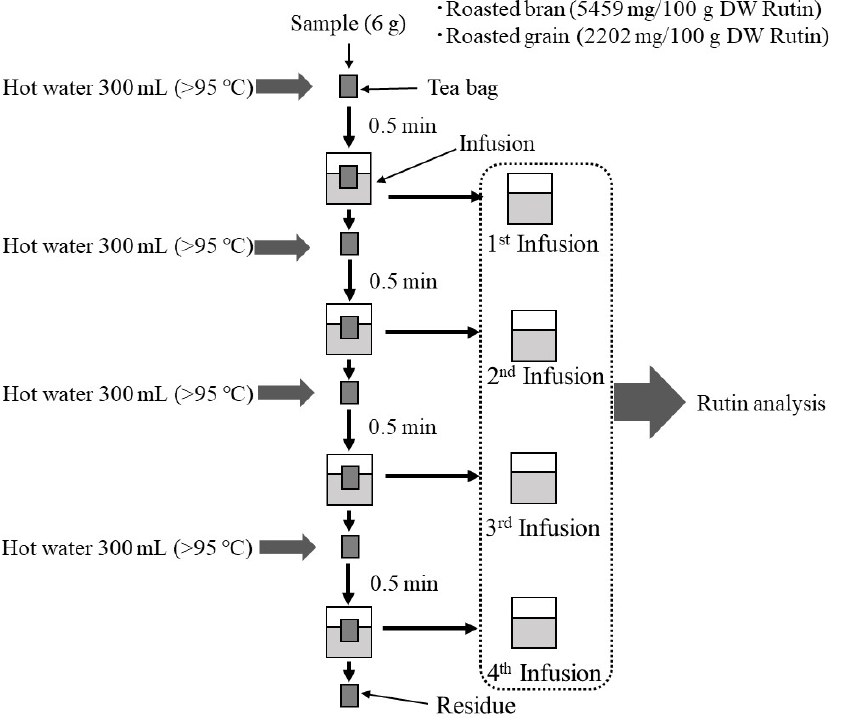
Figure 1. Flow diagram of rutin analysis of Tartary buckwheat bran and grain tea infusion samples. Although the solubility of rutin in cold water is unsatisfactory (0.13 g/L), its solubility in water increases sharply with temperature [22]. Thus, hot water treatment is a convenient, cheap, and environmentally friendly process for the extraction of rutin. Next, the first through fourth infusion tests of roasted Tartary buckwheat bran and grain were carried out using hot water (>95 ◦ C). The rutin content of the tea infusion samples in each test was determined; the results are given in Figure